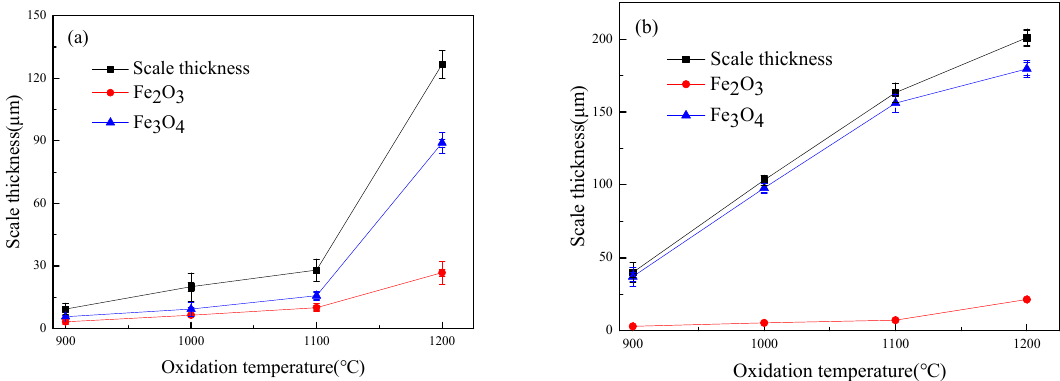
Figure 4. Oxide scale thickness of Fe–10Cr steel in different atmospheres. ( a ) Air; ( b ) air + 50% water vapor.